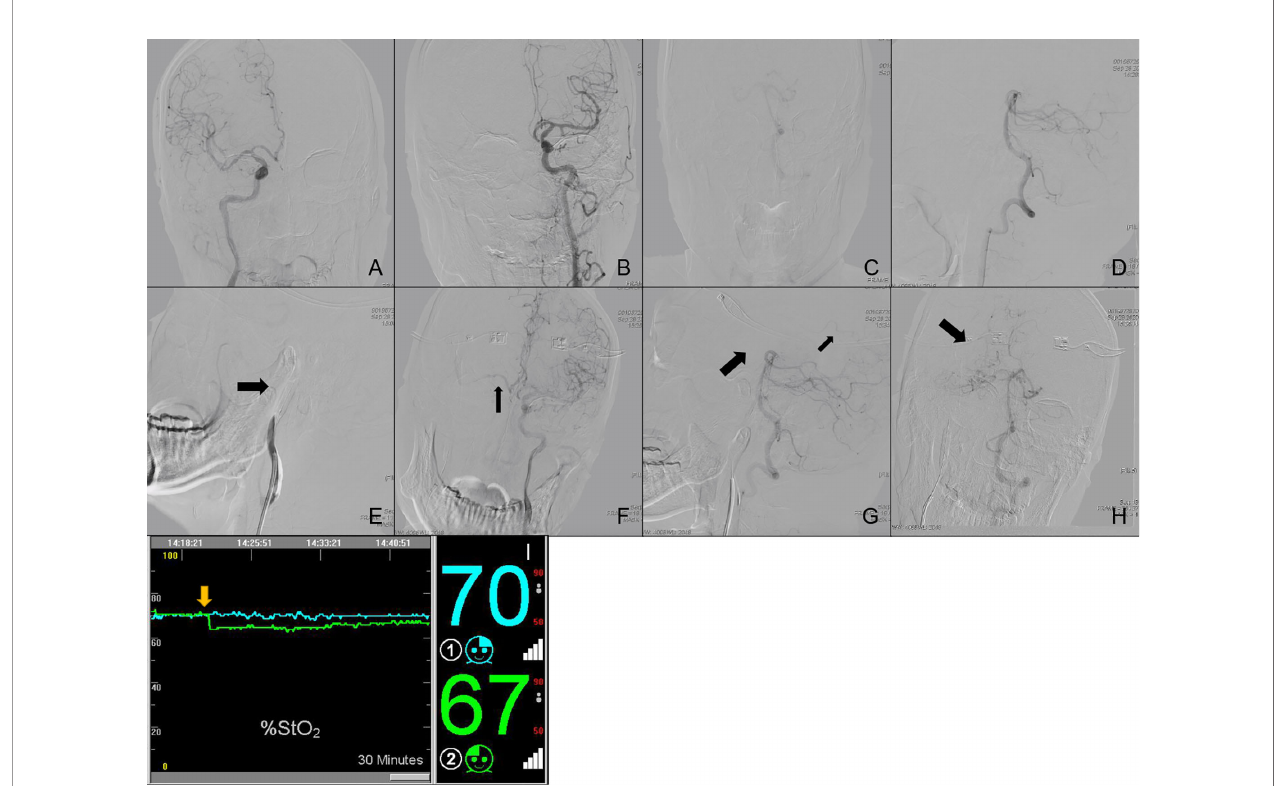
FIGURE 5 | Cerebral angiography and cerebral rSO 2 monitoring of Case No. 58. (A – H) Multi-side view of cerebral angiography. (I) Real-time rSO 2 monitoring. The blue line represented rSO 2 on the left cerebral hemisphere, the green line represented rSO 2 on the right cerebral hemisphere, the yellow arrow indicates a sudden drop in rSO 2